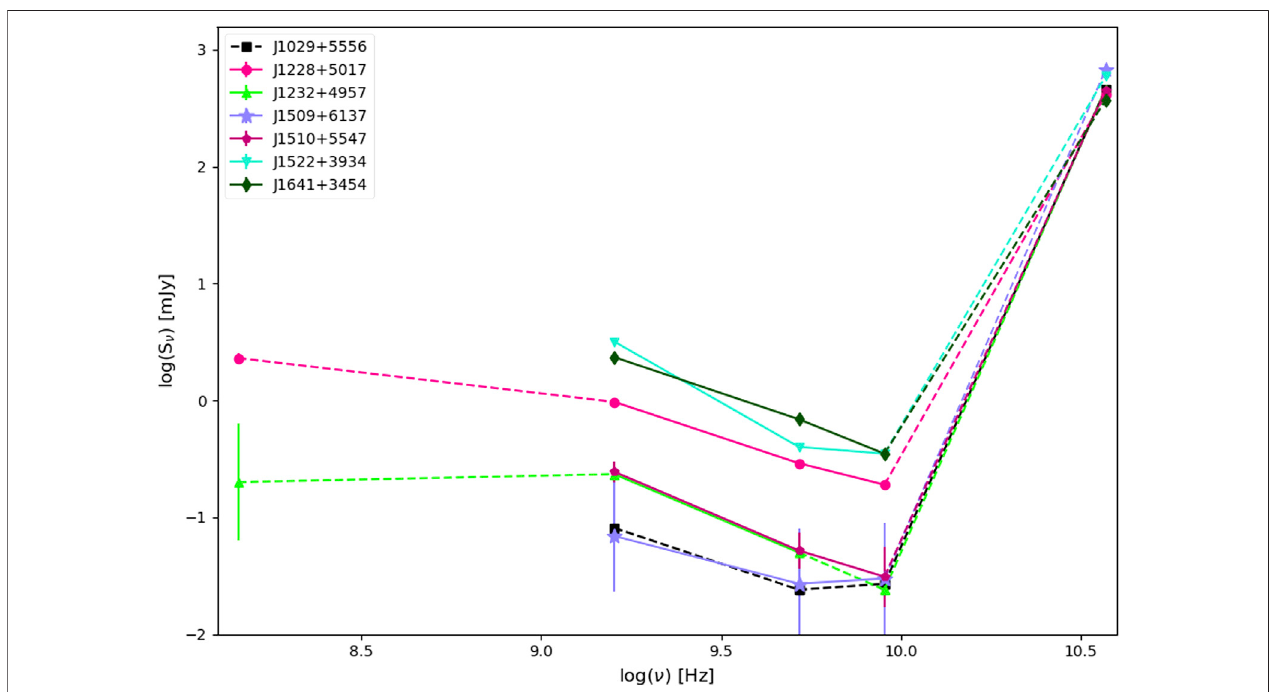
FIGURE1| Radiospectraofour sources from 144 MHz to37 GHz. The JVLA data forJ1228 + 5017,J1522 + 3934,and J1641 + 3454from this paper, forother sourcesfromB20.Simultaneousdetectionsareconnectedwithasolidline,archivaldetectionsandupperlimitswithadashedline.Thecoloursandsymbolsexplainedin the